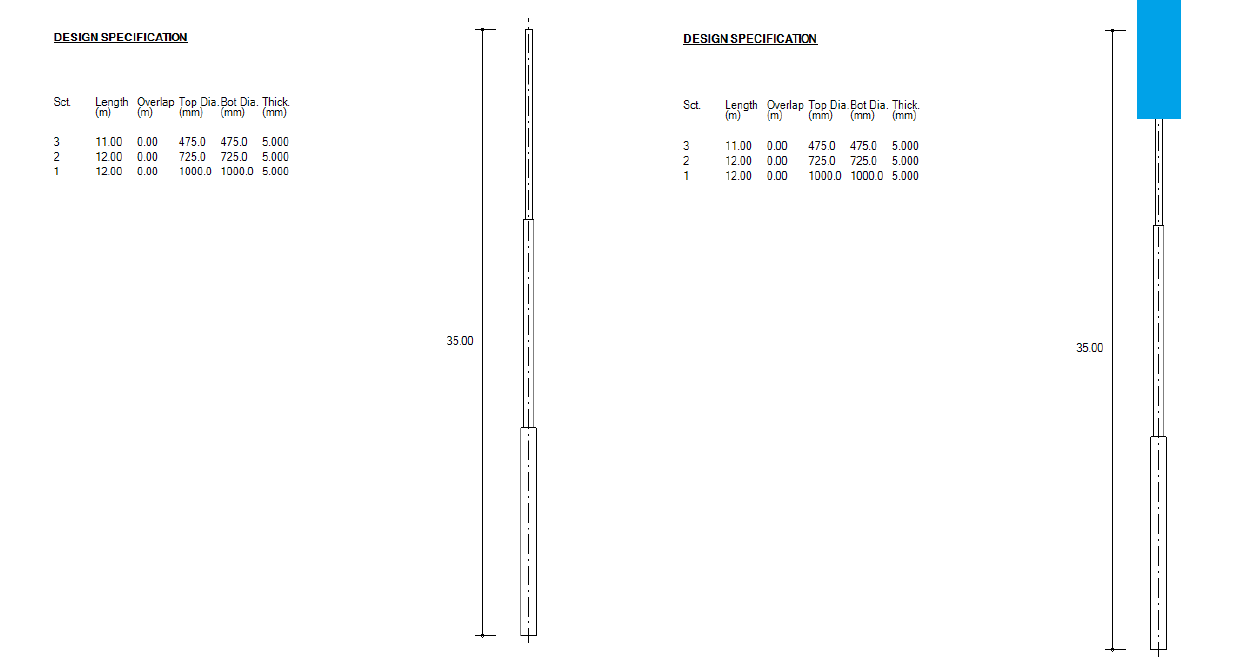
Figure 1. Geometrical configuration of monopole without camouflaged and monopole with camouflaged (height = 35m and basic wind speed =